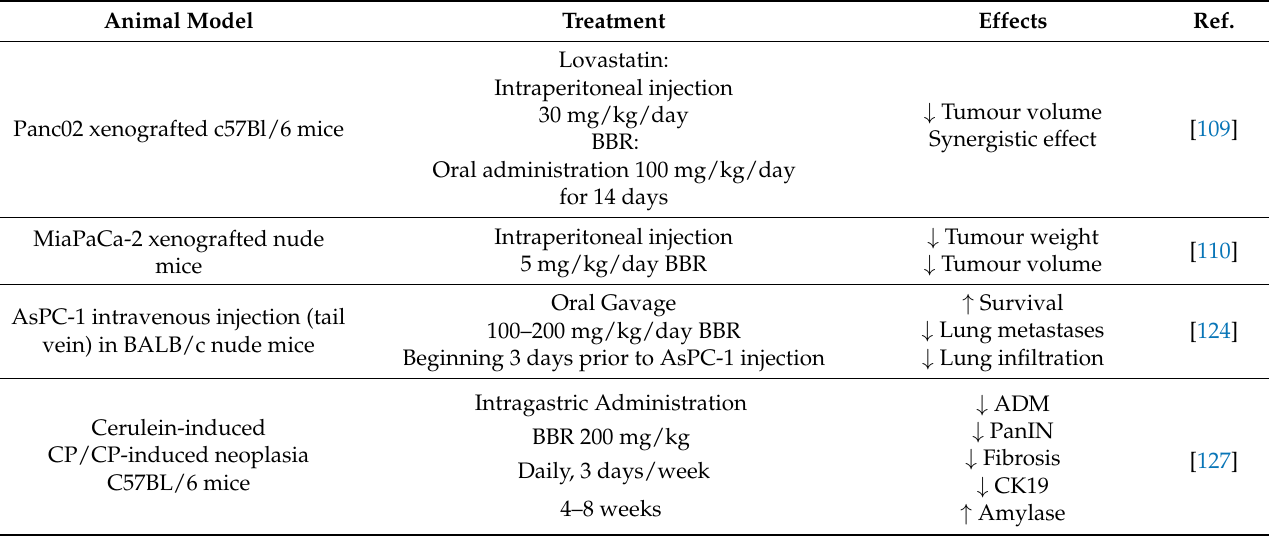
Table legend: ↑ increases, ↓